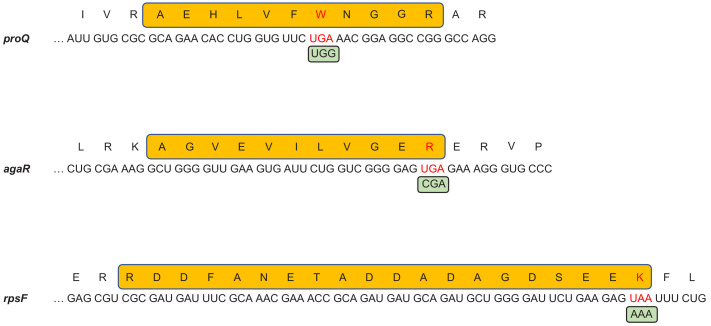
Stop codon bypass by near-cognate aminoacyl-tRNA misincorporation.Api-induced 0-frame stop codon bypass occurs via decoding of the stop codon by a near-cognate aminoacyl-tRNA. Three peptides (yellow boxes), encoded by the mRNA sequences spanning the stop codons were identified by mass spectrometry in the cells exposed to 0.5× MIC of Api. The nucleotide sequences of the 3’-proximal segments of the corresponding ORFs and amino acid sequences of the encoded proteins are shown. Stop codons and amino acids erroneously incorporated at stop codons are shown in red. The codon recognized by aminoacyl-tRNA that likely decoded the stop codon is shown in green boxes.